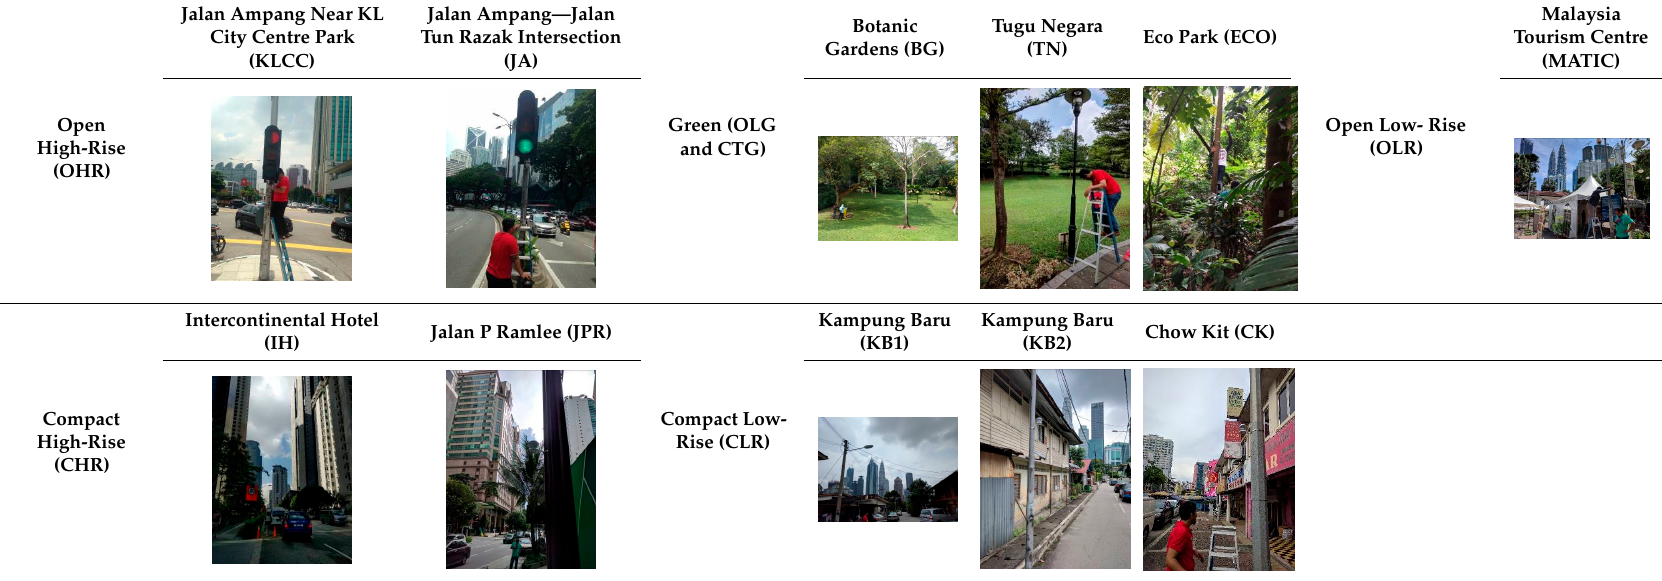
Table 1. On-site monitoring locations (photos taken by K. Wang and M. Othman in 2017).